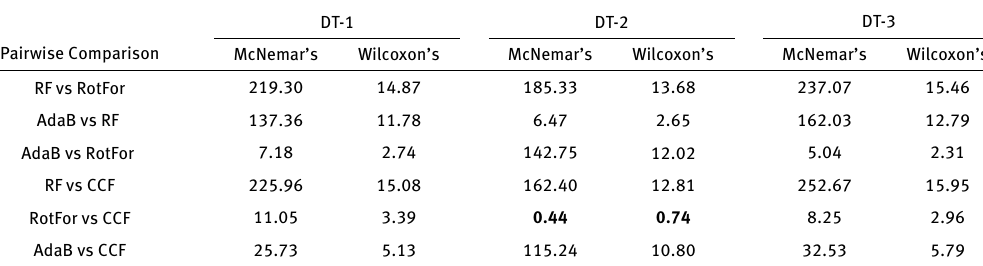
Table 3: Statistical Comparison of Classifier Performances.